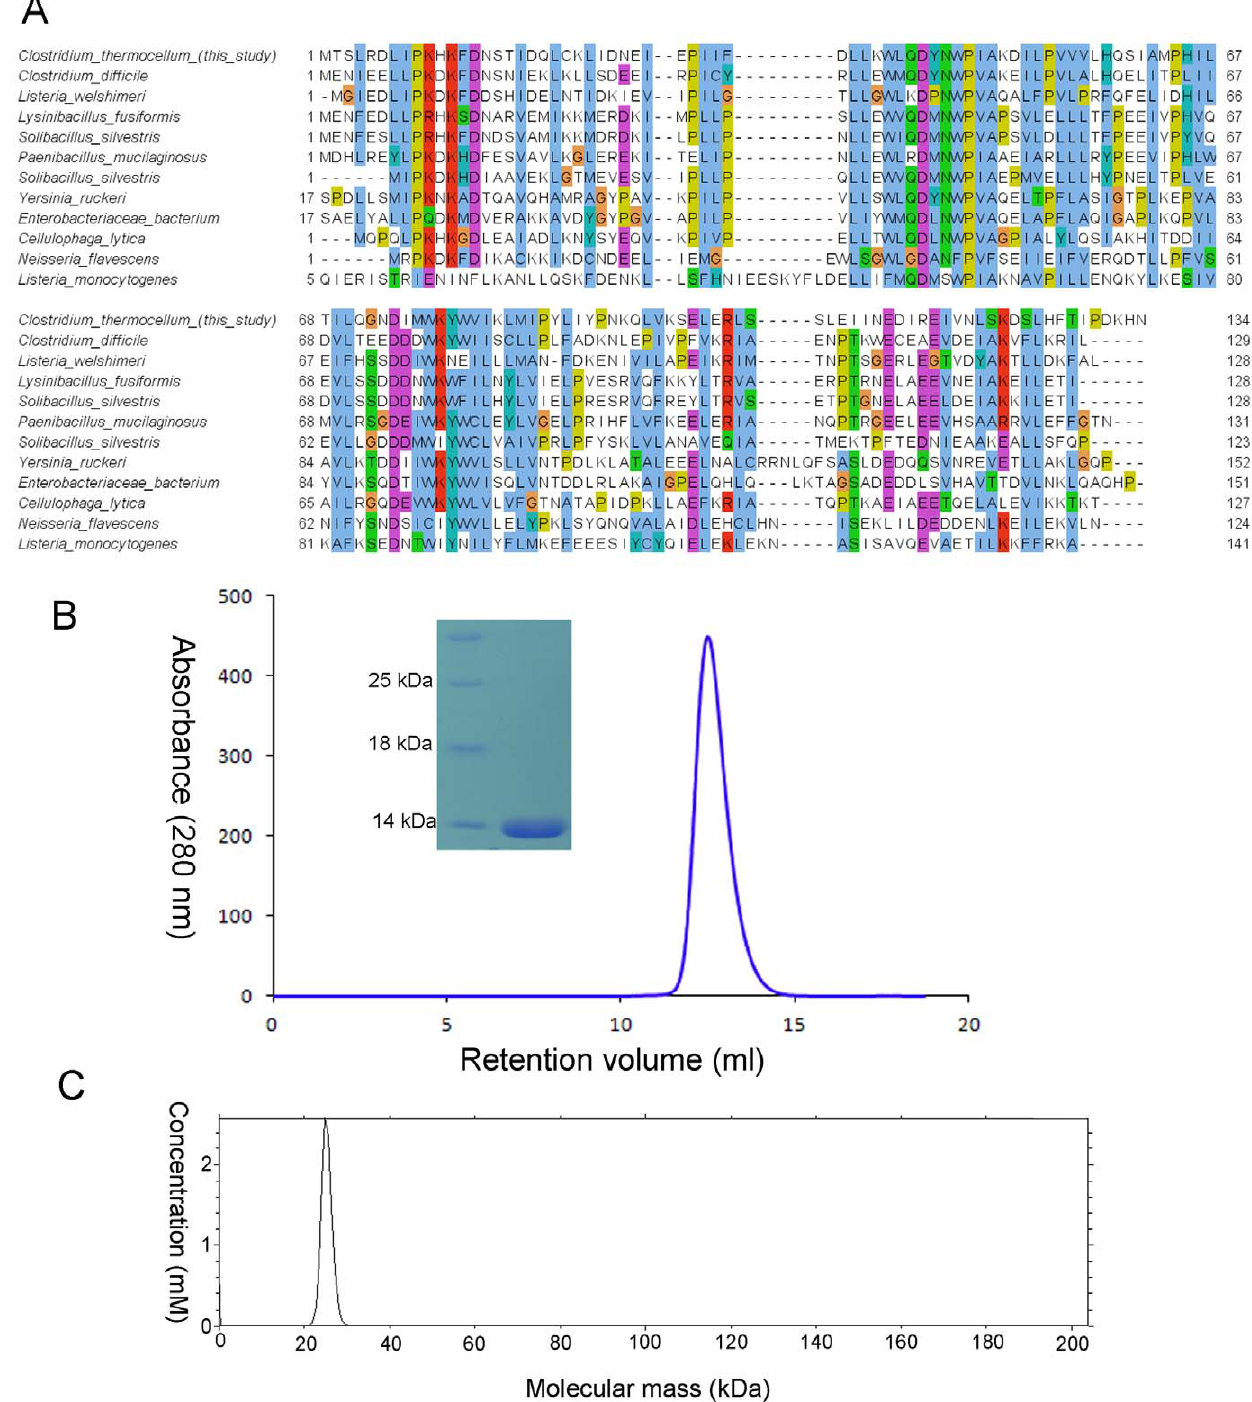
Figure 1. Characterization of Cthe_2751 (A) Sequence alignment of Cthe_2751 homologues. Only the top 11 matches with Cthe_2751 amino acids 1–134 are shown. Conservation is colored according to ClustalW convention. (B) Size exclusion profile of Cthe_2751 run on Hi Load 10/ 300 Superdex G75 gel filtration column equilibrated with 20 mM Tris-HCl, 100 mM NaCl, pH 8.0, reveals that the protein exists as a dimer in solution. SDS-PAGE picture (inset) showing the purity of Cthe_2751 before crystallization. (C) Sedimentation velocity experiments performed using an analytical ultracentrifuge suggested that Cthe_2751 forms a dimer in solution. The curve was generated using Sedfit software.